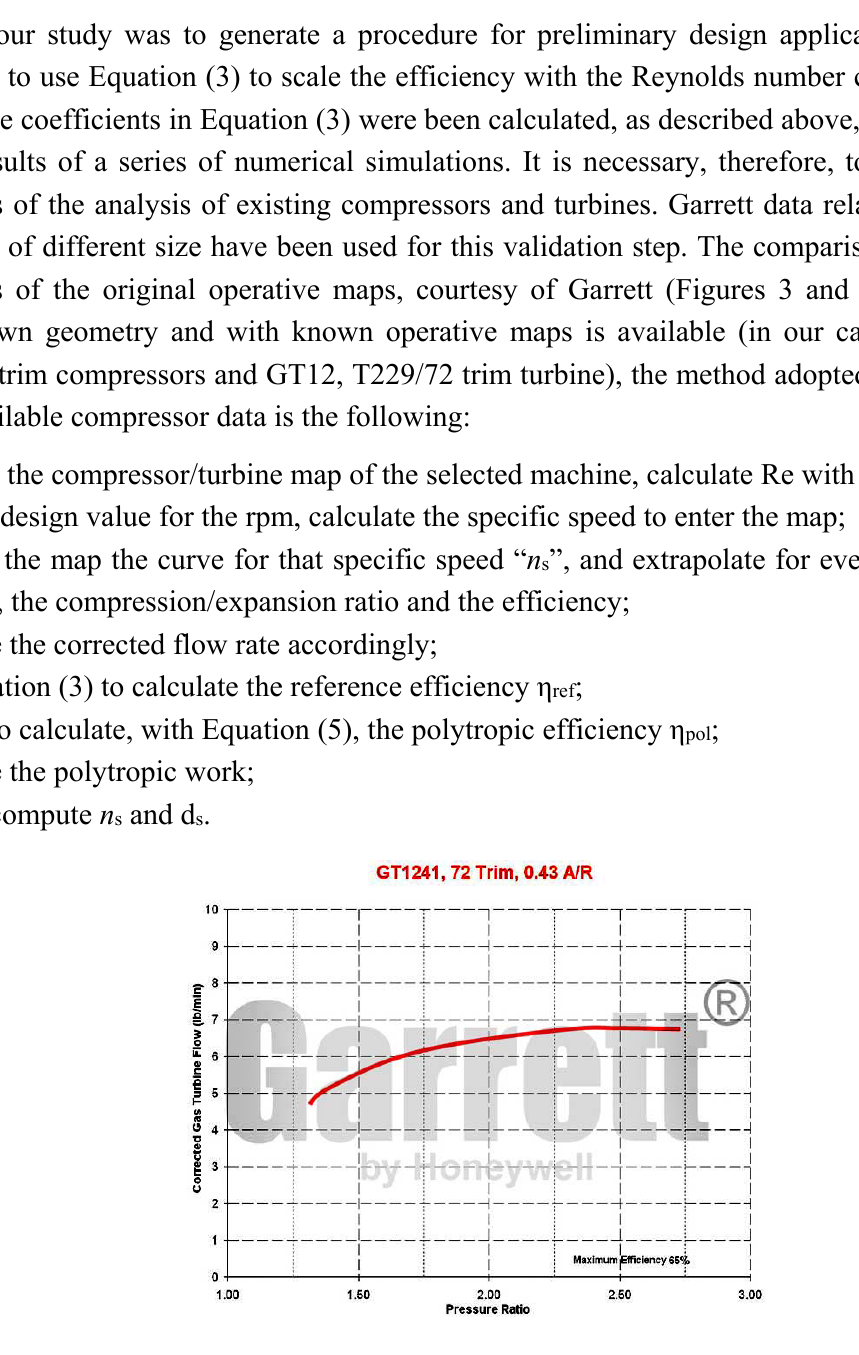
Figure 4. Typical Honeywell/Garrett ® turbine maps. Reprinted with permission from